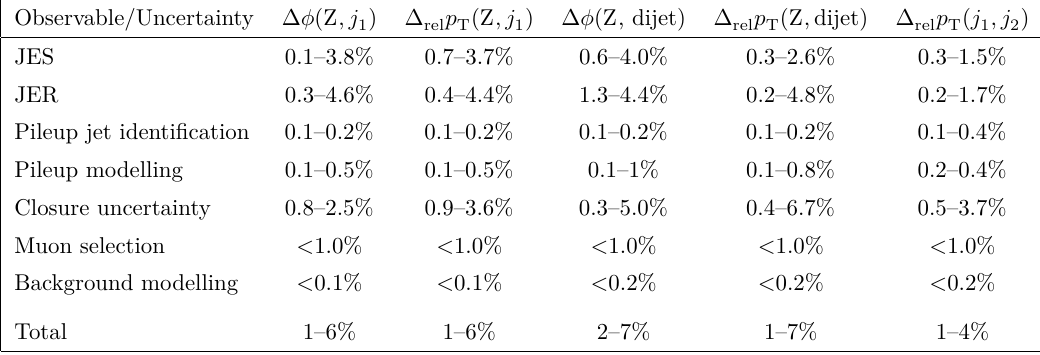
Table 4 . Uncertainty sources and their effect on the area-normalized